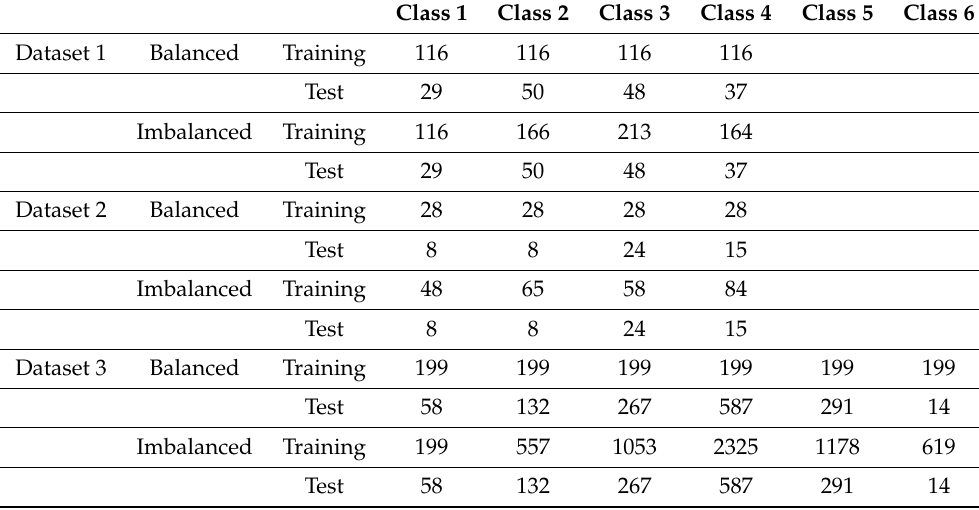
Table 1. Dataset compositions for the three case